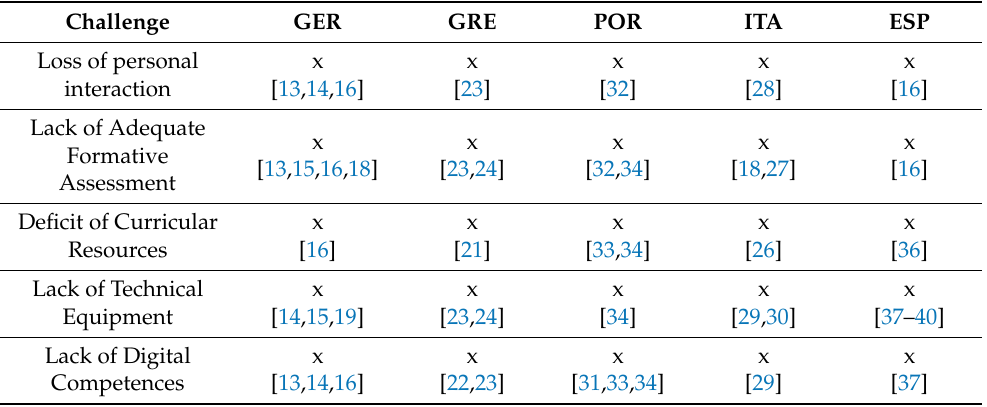
Table 1. Overview of the challenges regarding distance education that were encountered in Ger- many (GER), Greece (GRE), Portugal (POR), Italy (ITA), and Spain